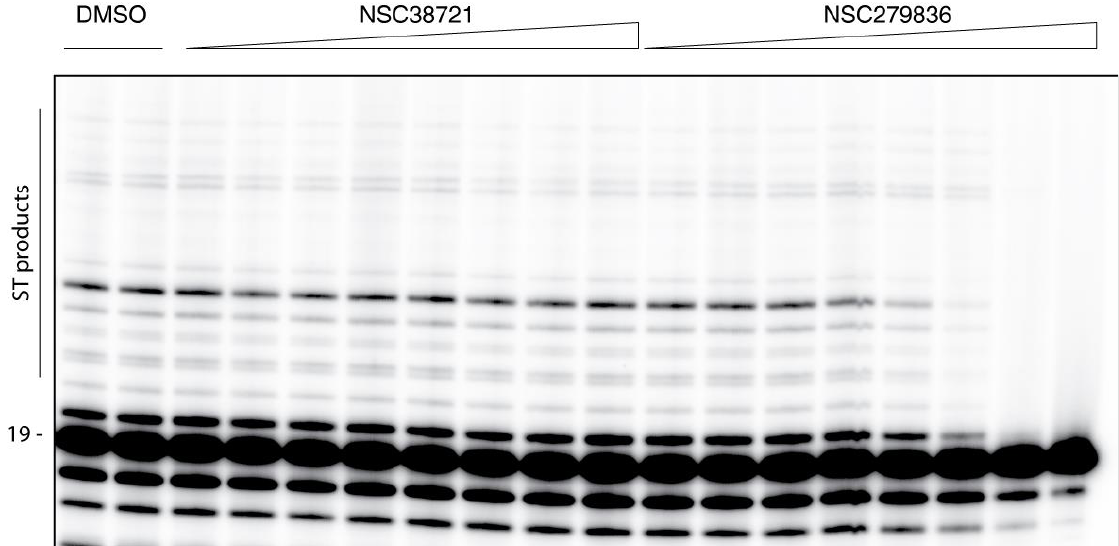
Figure 5. Effect of modulators on IN strand transfer activity. In this assay, only IN was present using serial dilutions of molecules from 100 µM to 45.7 nM following a 3-fold decrease. This representative image shows an inactive compound NSC38721 in parallel to an active compound, NSC279836. The first two lanes correspond to a DMSO control plus IN.